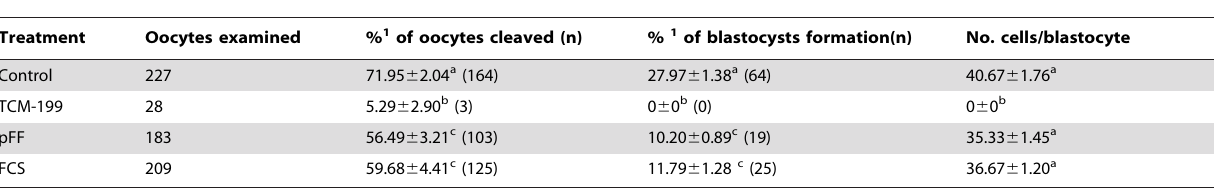
Table 5. Effect of preserving medium on early development of IVM-IVF porcine oocytes after preservation at 27.5 u C for 3 d.